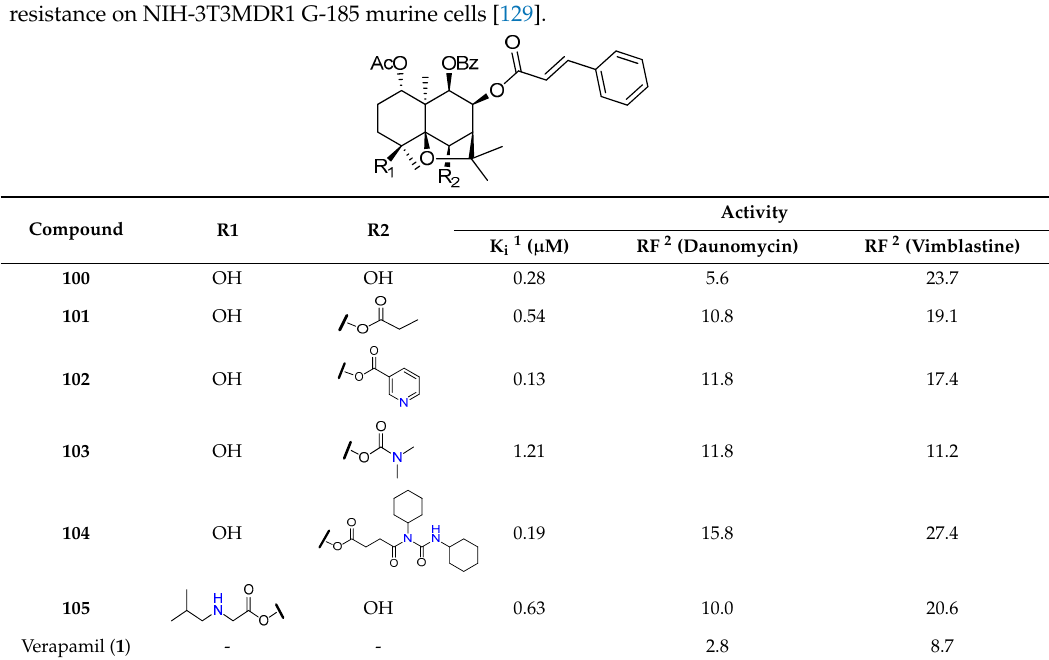
Reversal fold: indicate the ability of the tested compounds to reduce resistance of multidrug resistance cells to daunomycin/vinblastine. RF values were calculated by the ratio between IC 50 of daunomycin or vinblastine in the absence and in the presence of the tested sesquiterpene derivatives at 1 µM.